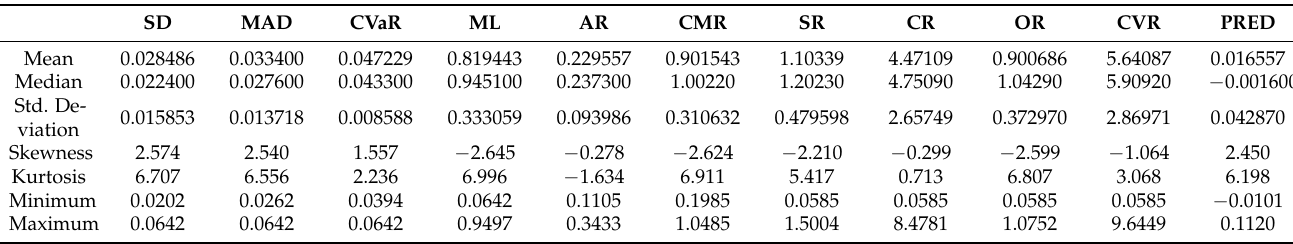
Table A2. Descriptive statistics for